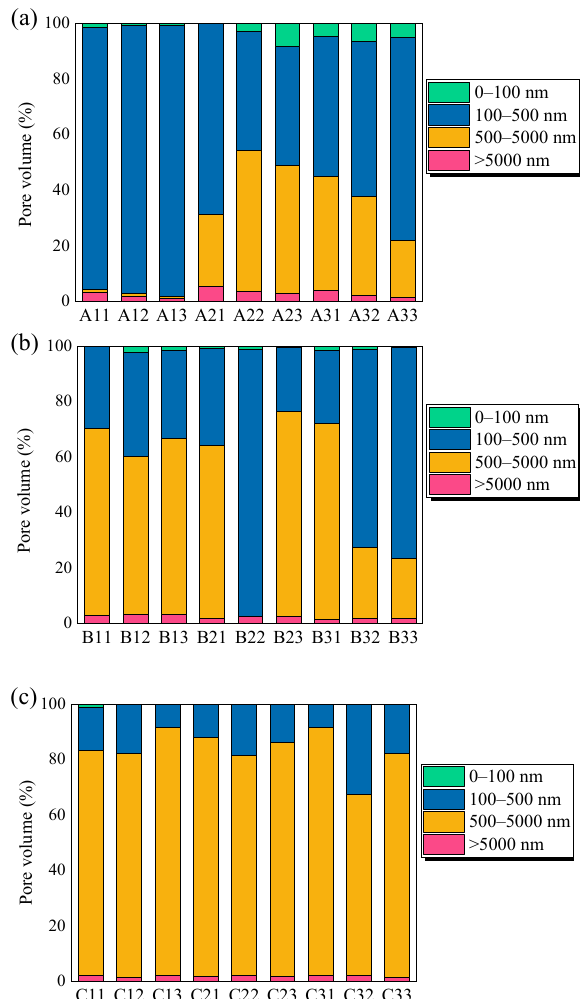
Figure 2. Pore volume fraction of porous alumina samples with different pore-forming agent con- tents. ( a ) 30 vol.% pore formers + 70 vol.% alumina; ( b ) 50 vol.% pore formers + 50 vol.% alumina; ( c ) 70 vol.% pore formers + 30 vol.% alumina.